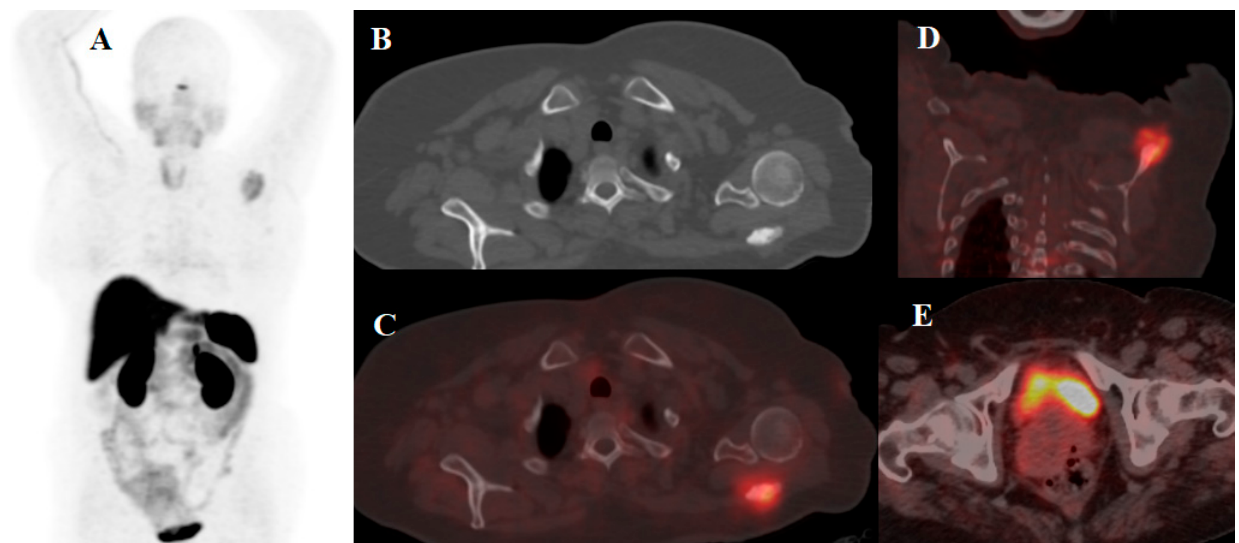
Figure 3. A 49-year-old woman with a history of NET of the cervix treated with local external beam radiotherapy referred for [ 68 Ga]Ga-DOTA-TATE PET/CT scan due to left shoulder pain. ( A ) MIP image shows avid lesion in the in left shoulder area. Axial CT scan ( B ) and fused axial and ( C ) coronal ( D ) PET/CT images showed a sclerotic somatostatin receptor avid lesion in the body of the scapula, suggesting a NET metastasis. Interestingly, the primary tumor is in remission after local treatment ( E ).